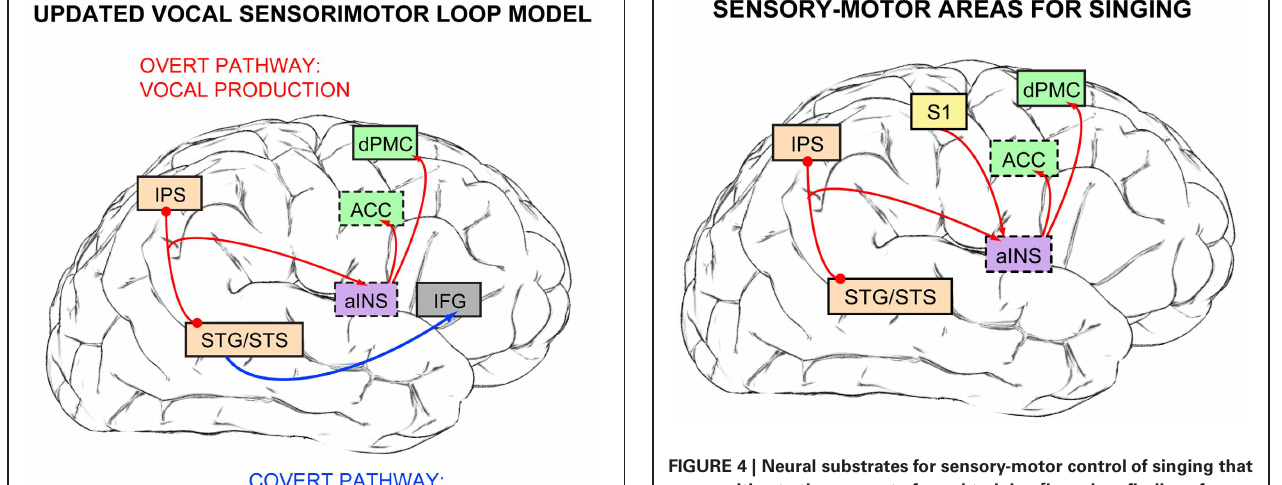
FIGURE 4 | Neural substrates for sensory-motor control of singing that are sensitive to the amount of vocal training [based on findings from Kleber et al. (2010, 2013), Zarate and Zatorre (2008), Zarate et al. (2010b)]. Brain regions that are not visible normally from this lateral brain view are indicated in boxes outlined with dashes, and box colors are retained from Figures 1 and 3 . Activity within primary somatosensory cortex (S1) increases as a function of the amount of weekly vocal practice, suggesting a greater reliance on somatosensory feedback with more training and experience. After extensive vocal training and practice, the anterior insula (aINS) can serve a gating function for somatosensory feedback. Features within auditory feedback are processed and extracted by auditory cortex (STG/STS) and the intraparietal sulcus (IPS), and task-relevant auditory information is sent via the aINS to the dorsal premotor cortex (dPMC)—in people with little to no formal vocal training—or to the anterior cingulate cortex (ACC) in experienced singers to voluntarily adjust vocal output according to the singing task